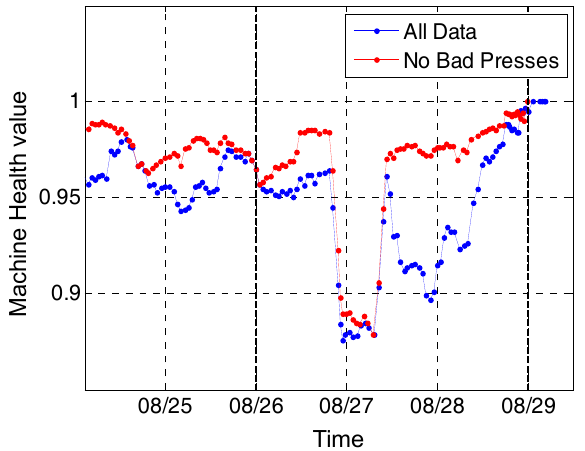
Figure 4. Calculated CV for the machine in stage 1 before removing the samples from stage 2 ( blue ) and after removing the samples from stage 2 ( red ) [25].